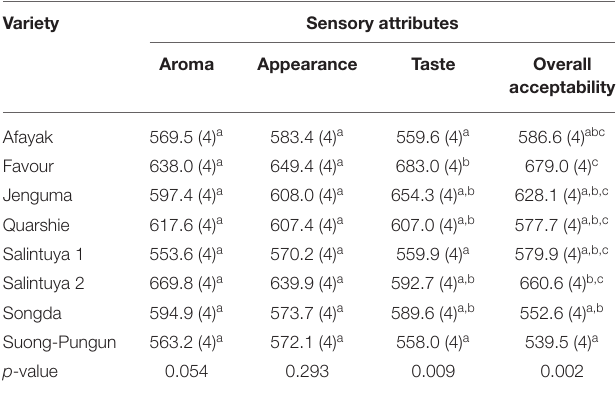
TABLE 2 | Consumer acceptability of soymilk from different varieties.